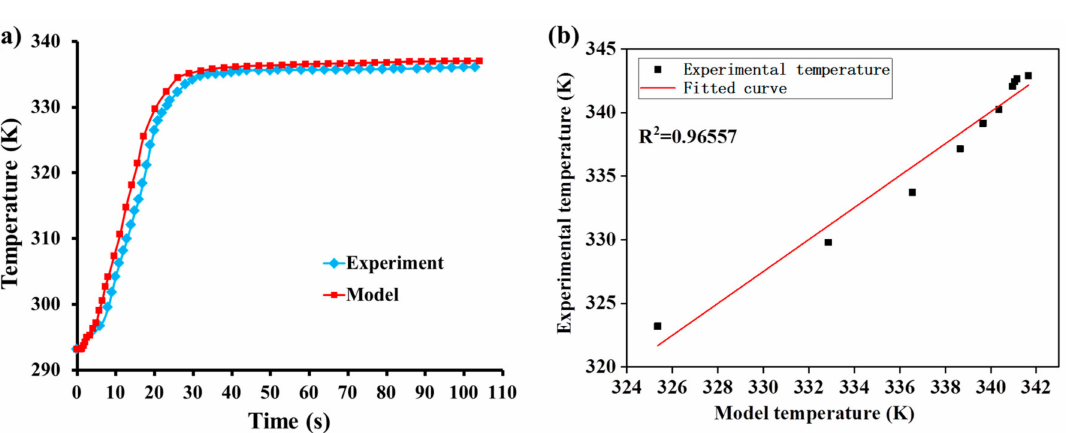
Figure 9. Comparison of temperature results obtained from the experiments and the model: ( a ) change of experimental and model temperature with time and ( b ) best-fit line for the